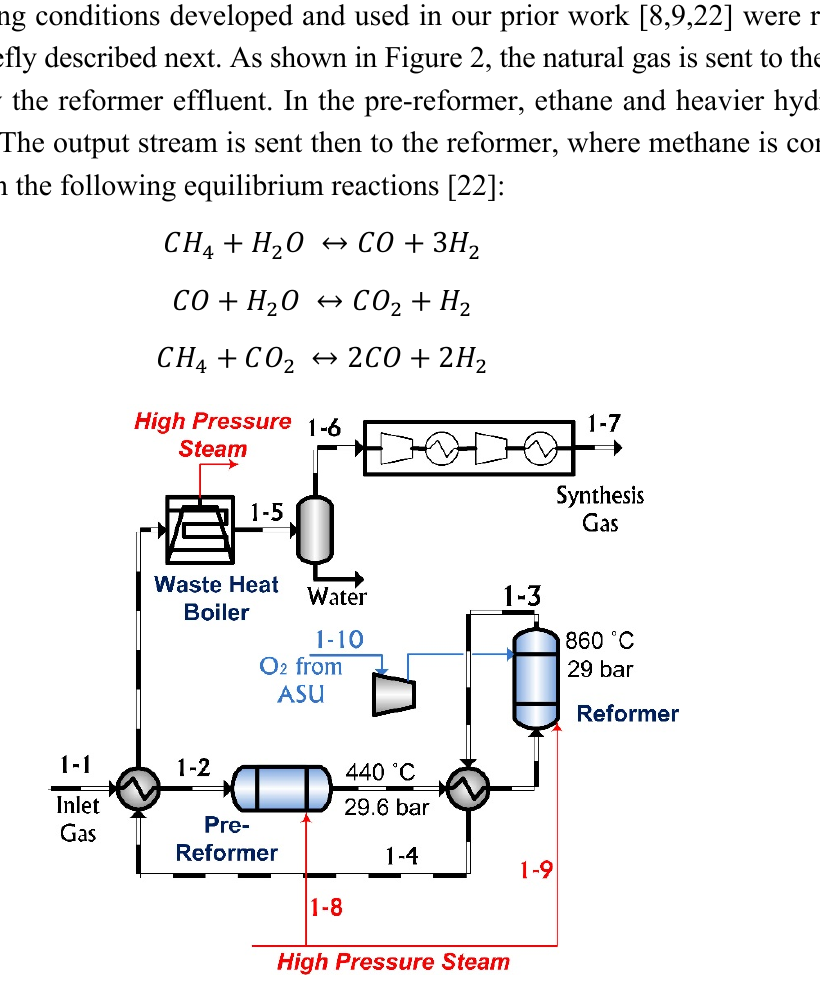
Figure 2. Section 1: Auto-thermal gas